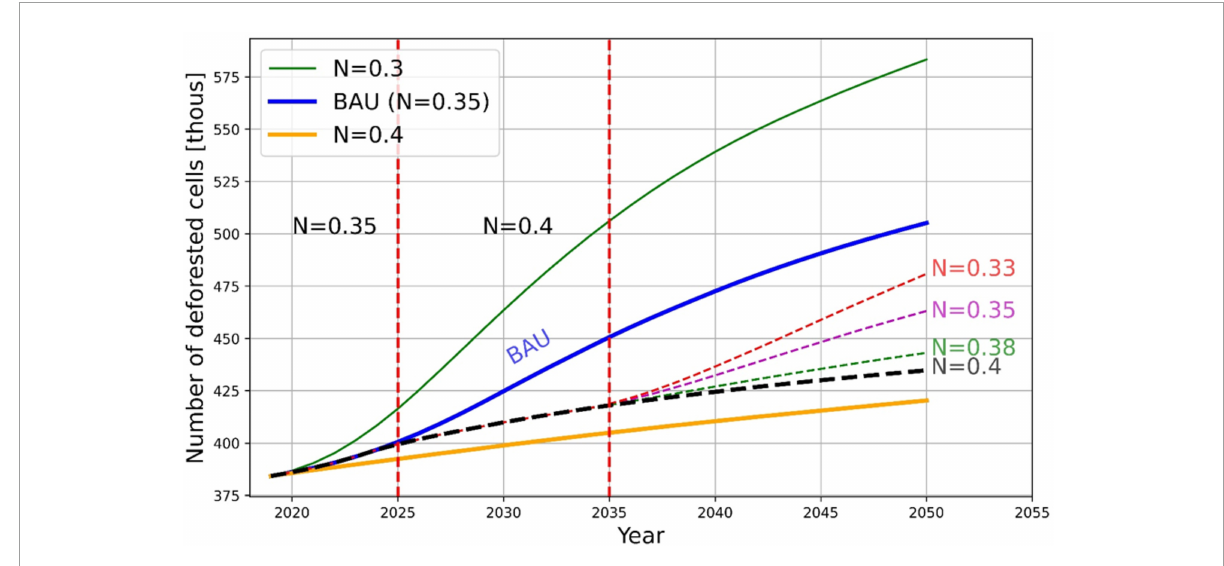
FIGURE8 Cumulative number of deforested cells.